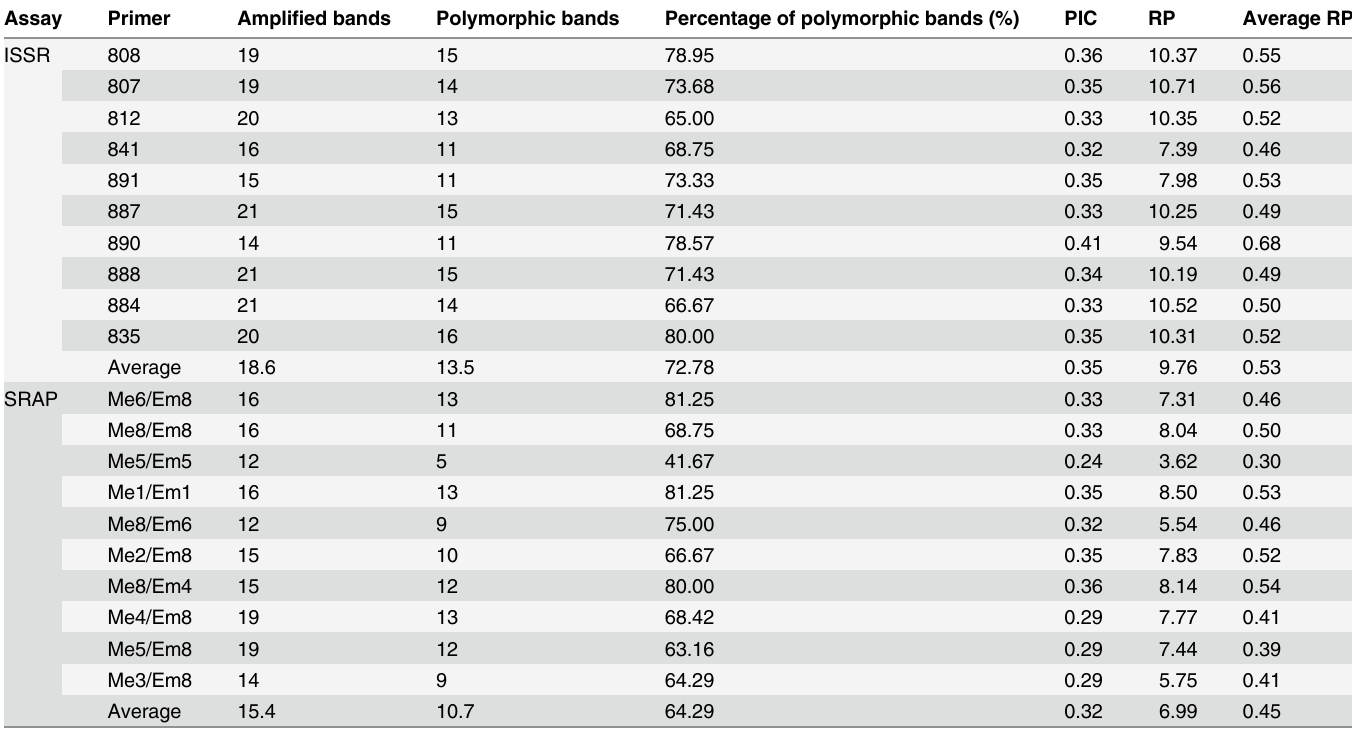
Table 4. PCR amplification of Blumeria graminis f. sp. tritici isolates using ISSR and SRAP primers. Assay Primer Ampli fi ed bands Polymorphic